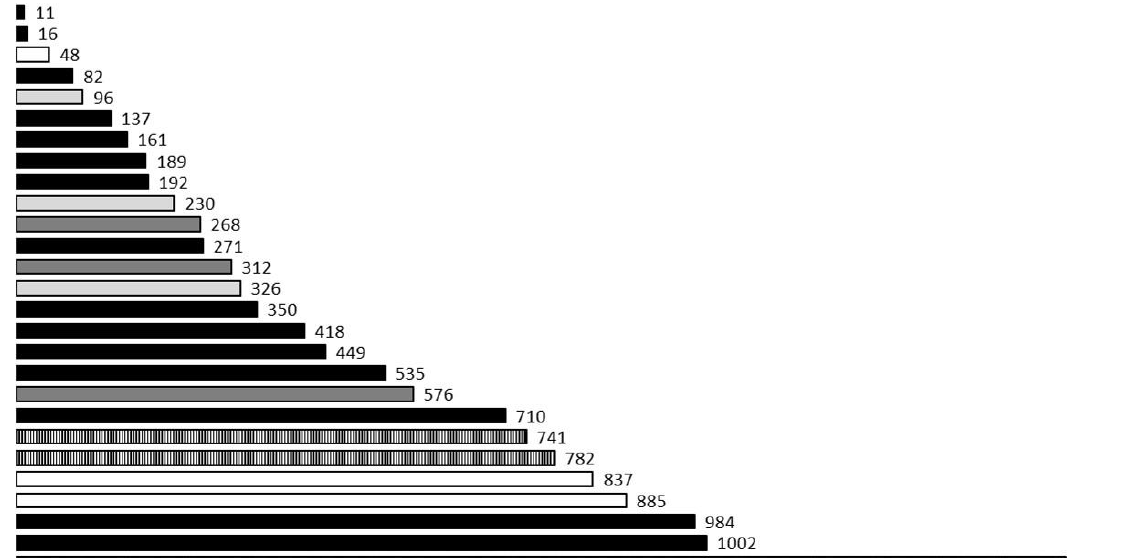
Figure 8. Estimated distance (in meters) between maned wolves exchanging roar-barks in sequences recorded simultaneously in 2 recorders. Non-black bars represent cases (4) where the same interactive sequence was recorded with enough quality in 3 recorders, and thus 3 different distances were calculated for each of them (using the time difference between recorders A × B, B × C, and A × C.). Including all relative distance values calculated ( N = 27), the estimated distance between individuals was 449.32 ± 374.36 m (mean ± SD). The two smallest values were 11 m